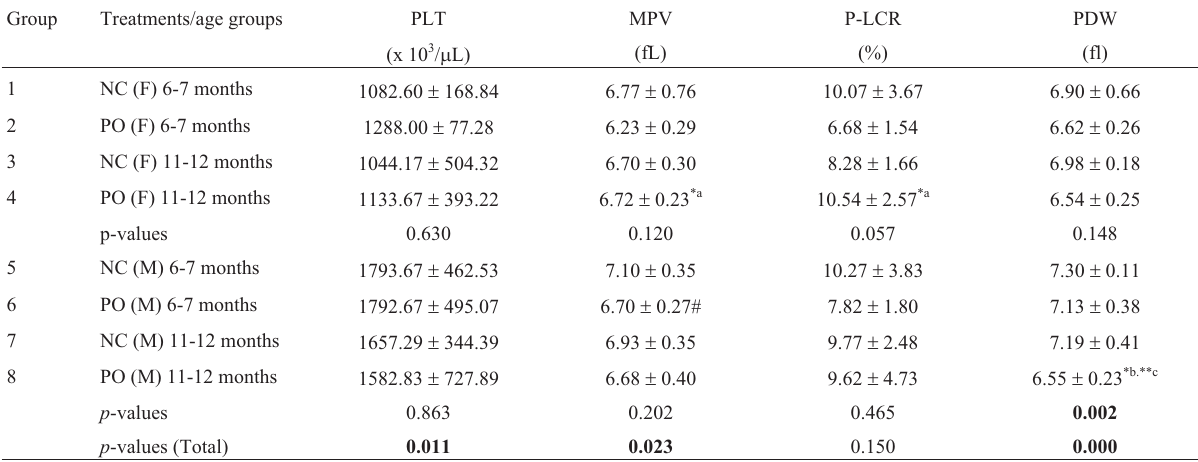
Table 5 - Results of plateletgram of elderly female (F) and male (M) Swiss albino mice after treatment with pequi oil (30 mg/animal/day) administered orally for 15 consecutive days. Negative controls (NC) received filtered water administered in the same way. Group Treatments/age groups